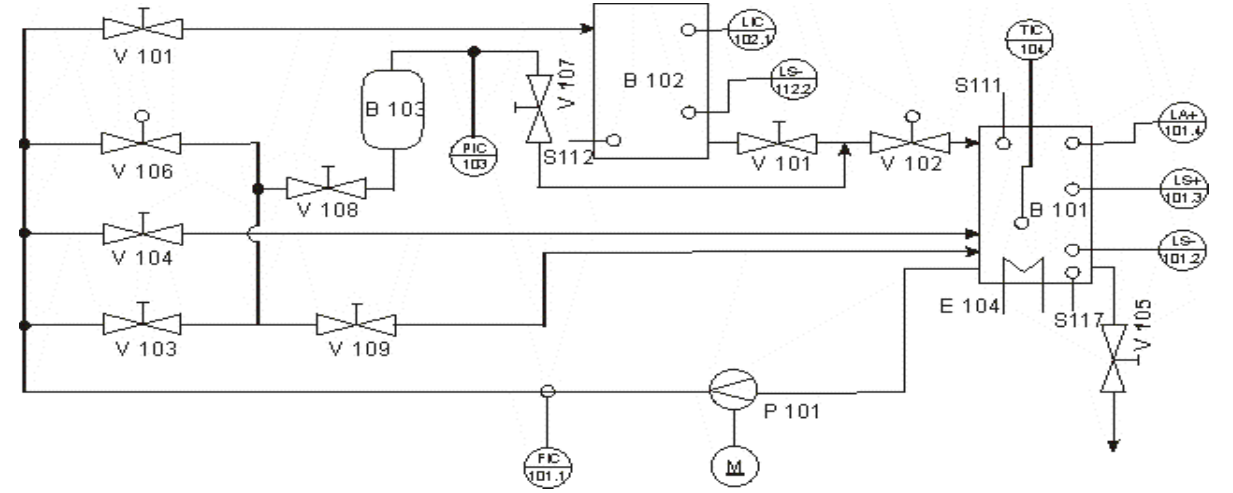
Figure 2. The functional scheme of the stand